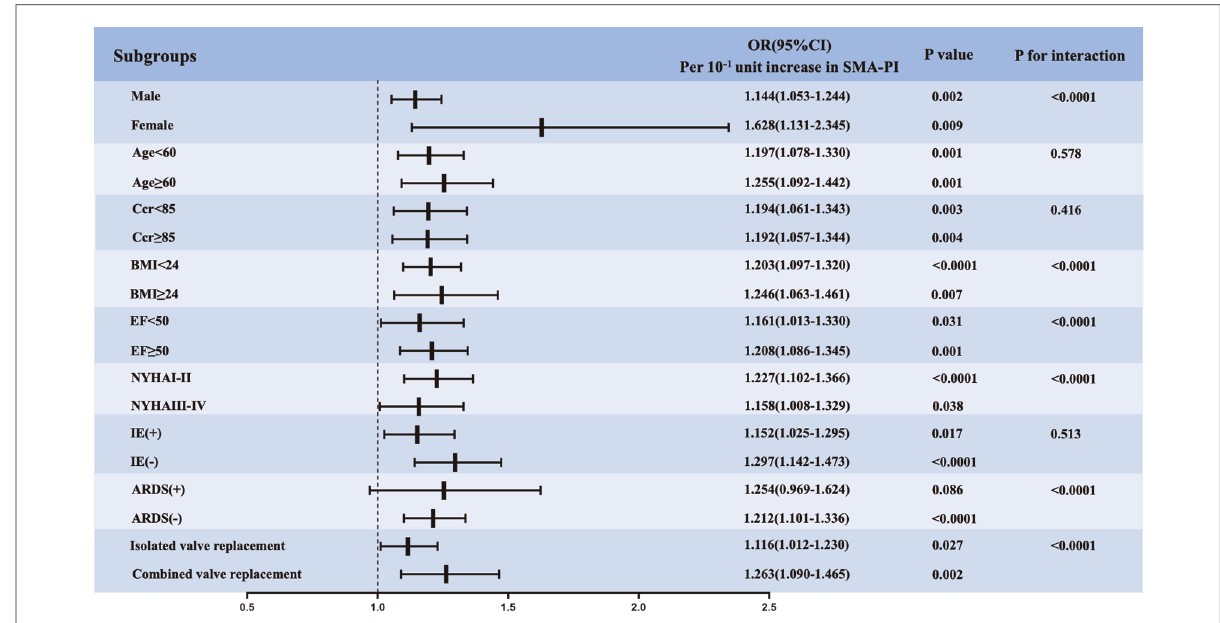
FIGURE 4 Logistic regression analysis evaluating the implication of SMA-PI in predicting PMV in subgroups. SMA-PI, the pulsatility index of the superior mesenteric artery; PMV, prolonged mechanical ventilation; Ccr, endogenous creatinine clearance rate; BMI, body mass index; EF, left ventricular ejection fraction before surgery; NYHA, New York heart association; IE, infective endocarditis; ARDS, acute respiratory distress syndrome; OR, Odds ratio; CI, con fi dence